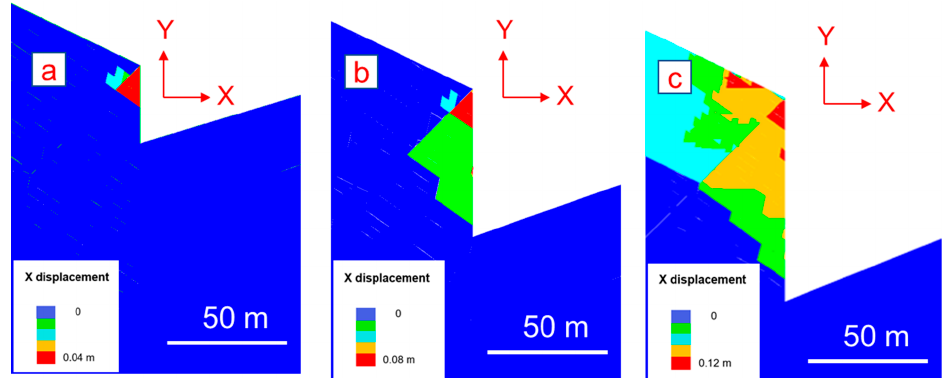
Figure 15. Close-up view of the contour of X displacement in the valley during sequential removal of rock blocks caused by the staged river erosion, ( a ) stage 1, ( b ) stage 2 and ( c ) stage 3.